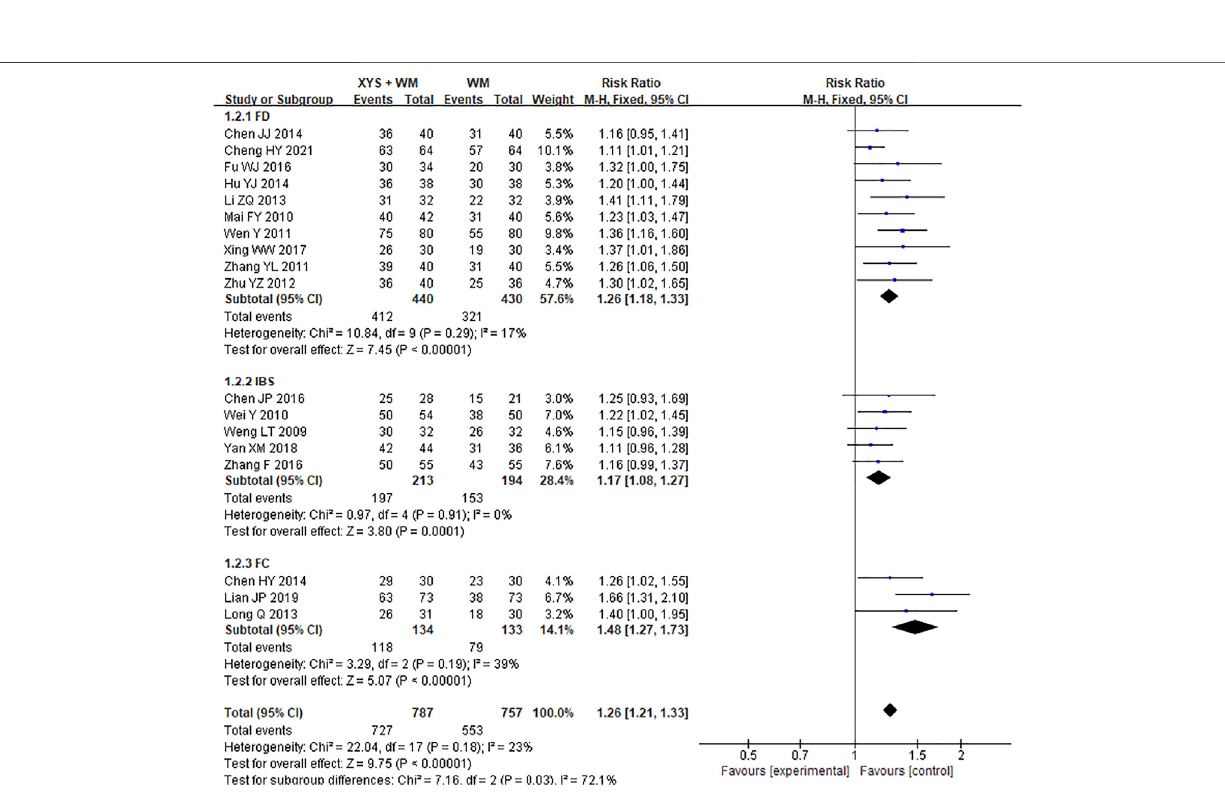
Frontiers in Pharmacology |